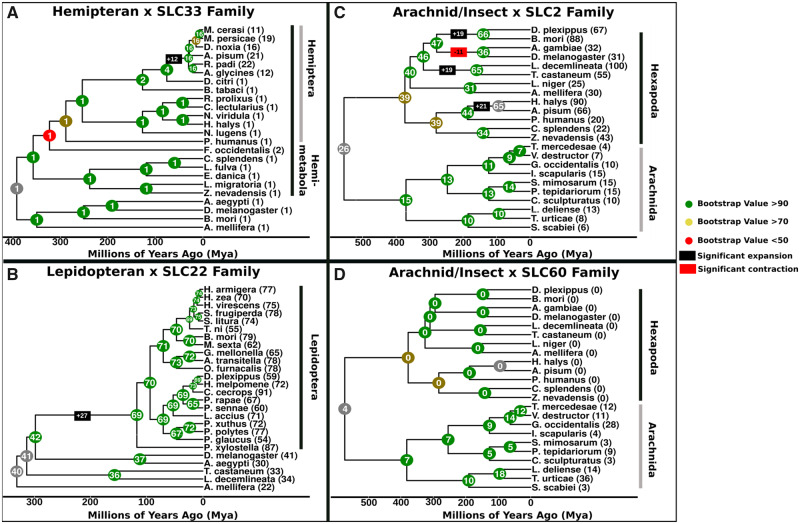
Phylogenetic analysis of SLC family size variation. CAFE was used to analyze the evolutionary fates of selected SLC families. (A) A hemipteran enriched tree considering the SLC33. (B) An arthropod-wide tree with SLC2 and an Arachnida enriched tree with (C) SLC35 and (D) SLC60. The color of each node corresponds to the bootstrap support of each node (red, <80; yellow, >80 and <90; green, >90; gray, NA). Numbers in parentheses next to each species represent the detected number of SLC family members in each species. All trees were calibrated for time and are plotted in terms of millions of years ago (Ma). Black and red boxes represent expansions supported by at least two species.